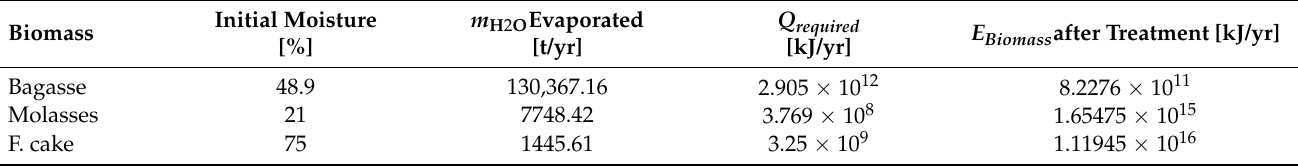
Table 4. Heat energy requirement for biomass moisture remove and available biomass energy after